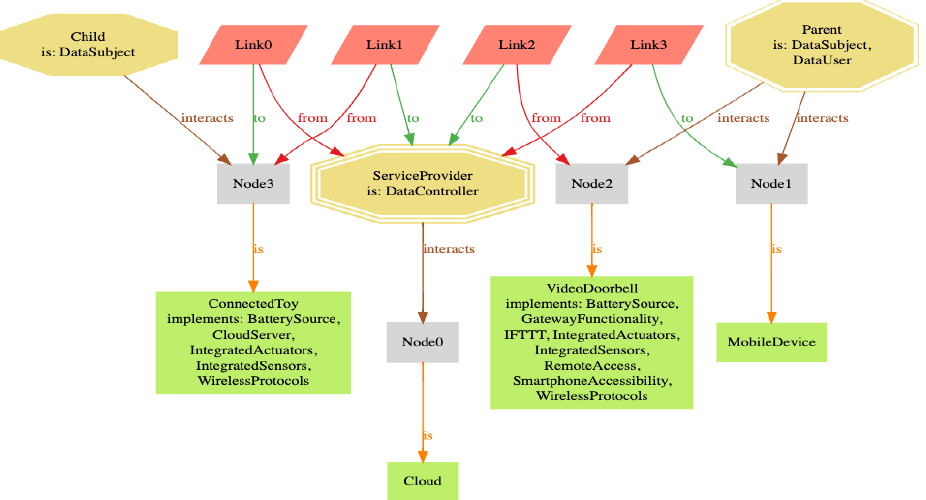
Figure 4. A smart home configuration generated using Alloy. The smart home setup consists of 4 nodes (ConnectedToy,VideoDoorbell,MobileDevice,Cloud), 3 users (Child,Parent,ServiceProvider), and 4 links (Link0-Link3) that interconnect users to nodes, and vice versa. All the relations between the different model components is displayed in the form of labelled